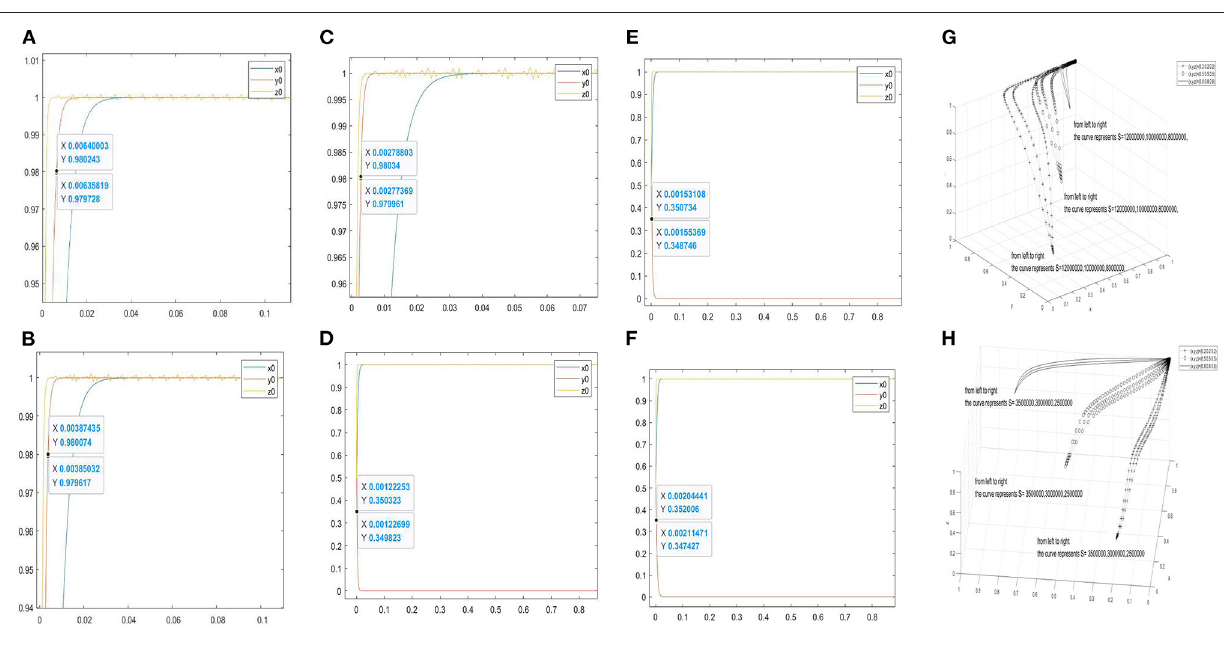
approach 1, and the increase of C 1( D 2 − E 1 − 6) will accelerate curves approach (1, 1, and